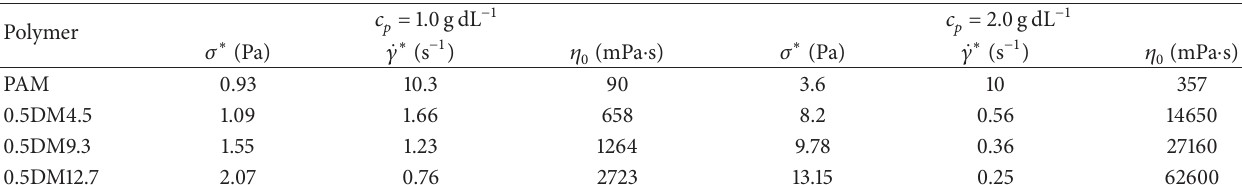
Table 2: Rheological values of 𝜎 ∗ , ̇𝛾 ∗ , and 𝜂 0 for poly(AM/DMDCC) and PAM at concentration of 1.0 gdL −1 and 2.0 gdL −1 . Polymer